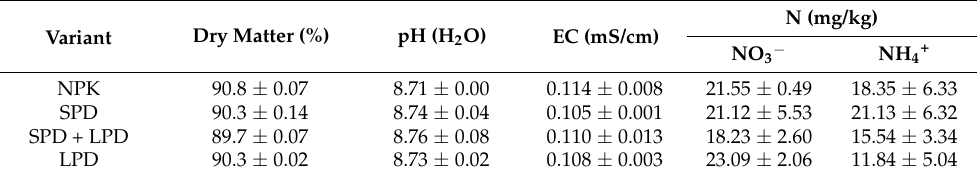
Table 9. Dry matter content, pH value, soluble salt value and mineral nitrogen content in soil samples after plant harvest.